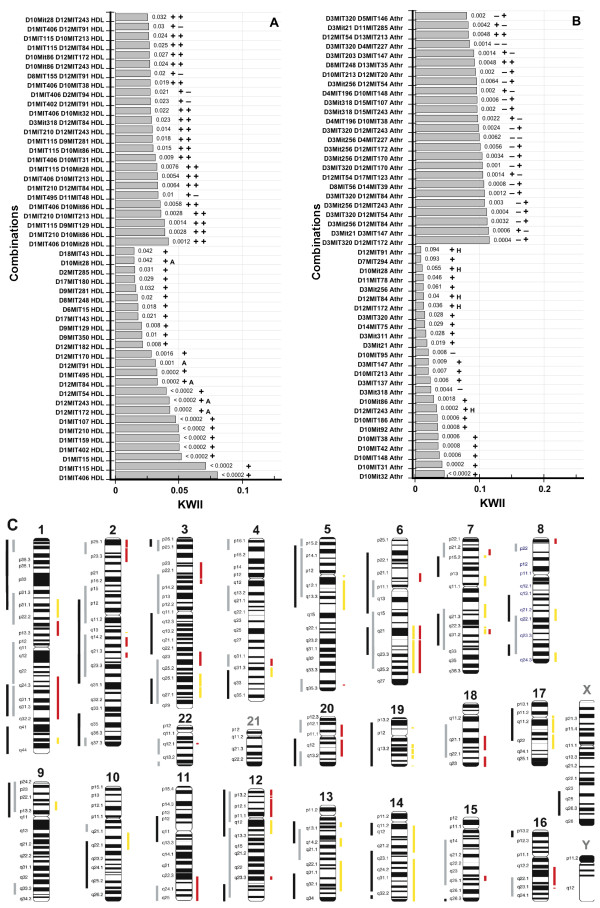
The KWII spectra for HDL (Figure 6A) and atherosclerotic lesion length (denoted by the variable Athr on the y-axis of Figure 6B). The p-values for each combination are shown against the bars. The plus symbol indicates that there is a human QTL reported for the orthologous region corresponding to the mouse marker and the minus symbol indicates that a human QTL has not been reported. For the two-variable combinations, the plus and minus symbols are placed in the same order as the y-axis labels. The A and H indicate if the marker is present in both the HDL and Atherosclerosis spectra. Figure 6C is a haploid human karyotype ideogram. To the right of each chromosome, the human orthologs of the HDL (red bars) and atherosclerotic streak length (yellow bars) associated mouse markers identified in our study are shown. To the left of each chromosome the human QTL for HDL (gray bars) and atherosclerotic disease (black bars) are shown. Chromosomes 21, X and Y contained no overlapping orthologs and their labels are shown in gray.